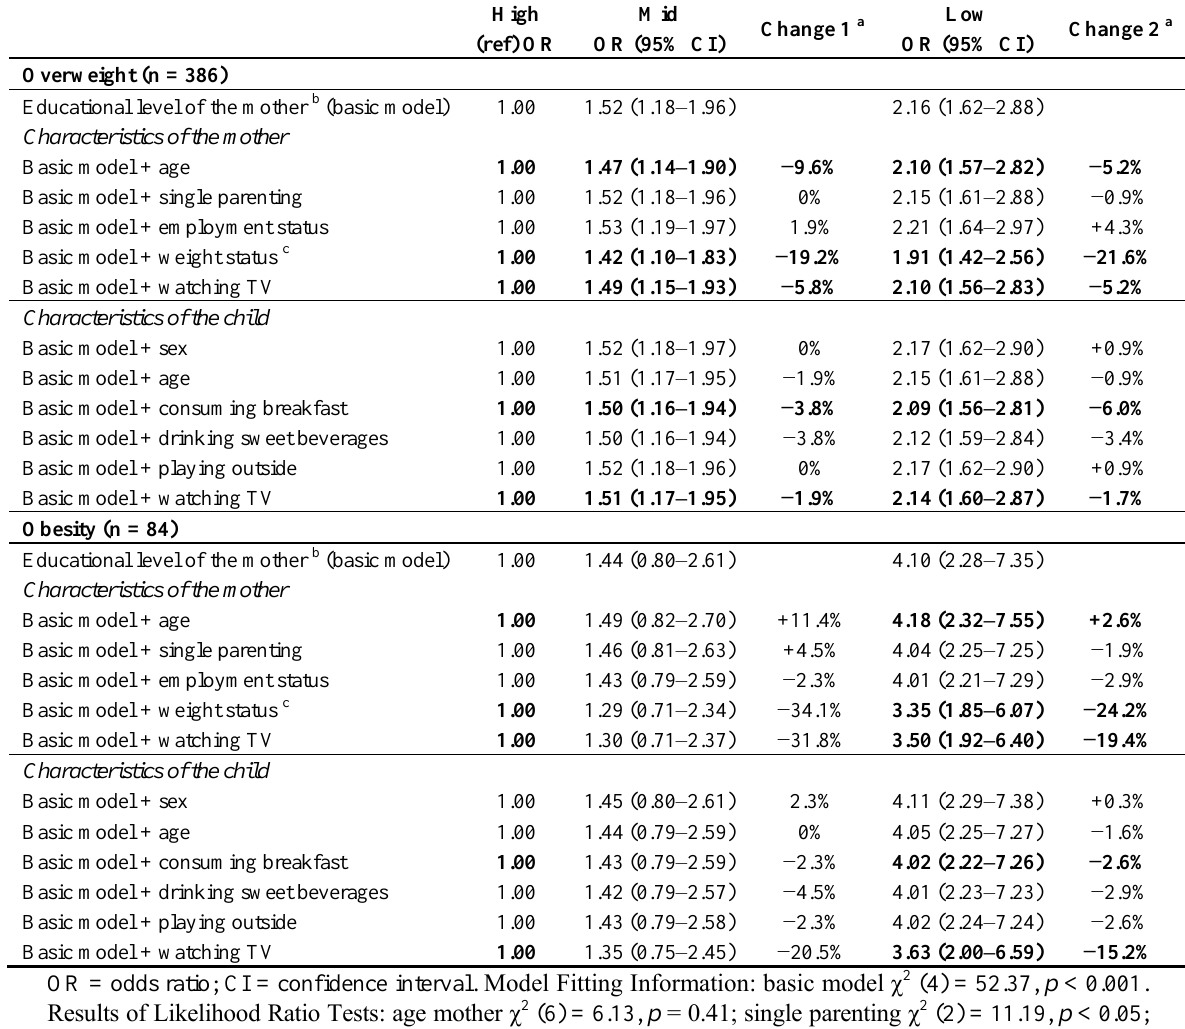
Table 2. Multinomial logistic regression analyses for the association between maternal educational level and children’s overweight and obesity, and change in ORs after adjustment for demographic and lifestyle-related characteristics of the mother and child (n =